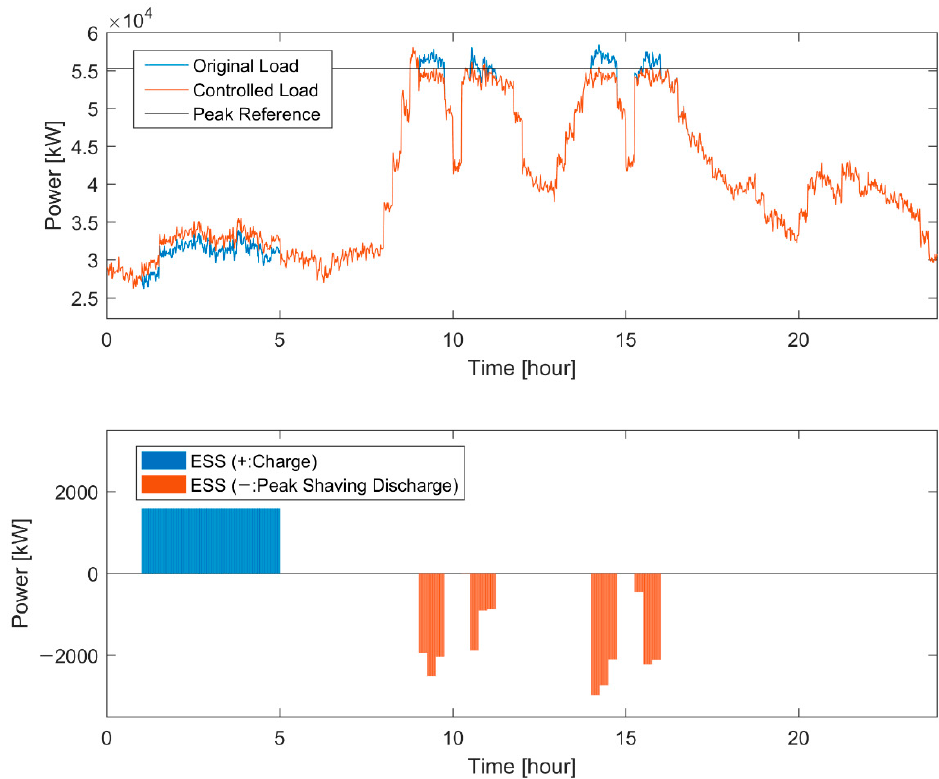
Figure 2. Example of the result of peak shaving with the conventional ESS-based DSM.